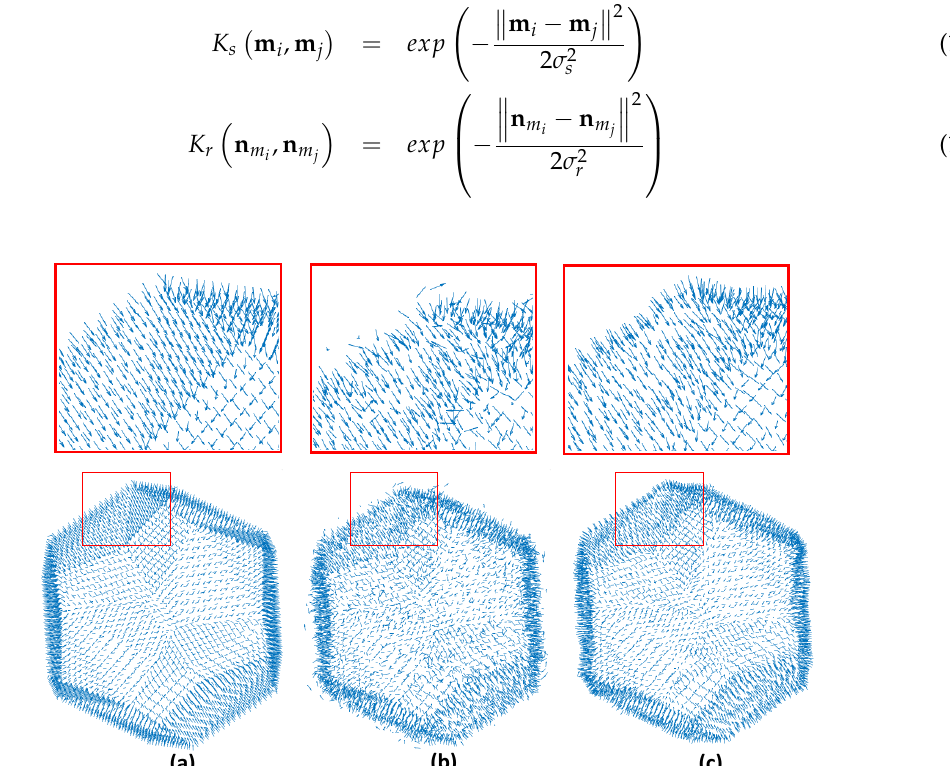
Figure 9. Face normals of: ( a ) The original noise-free mesh; ( b ) the noisy mesh; ( c ) Smoothed reconstructed